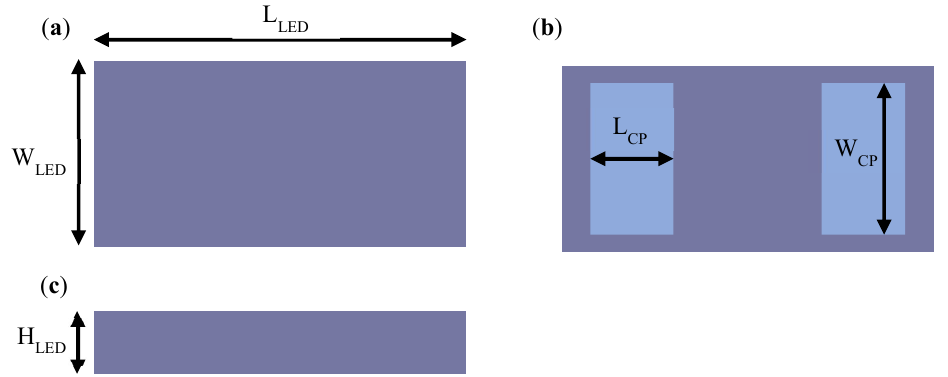
Figure 2. Structure of mini-LEDs: ( a ) top view; ( b ) bottom view; ( c ) side view. Adapted from ref. [48].